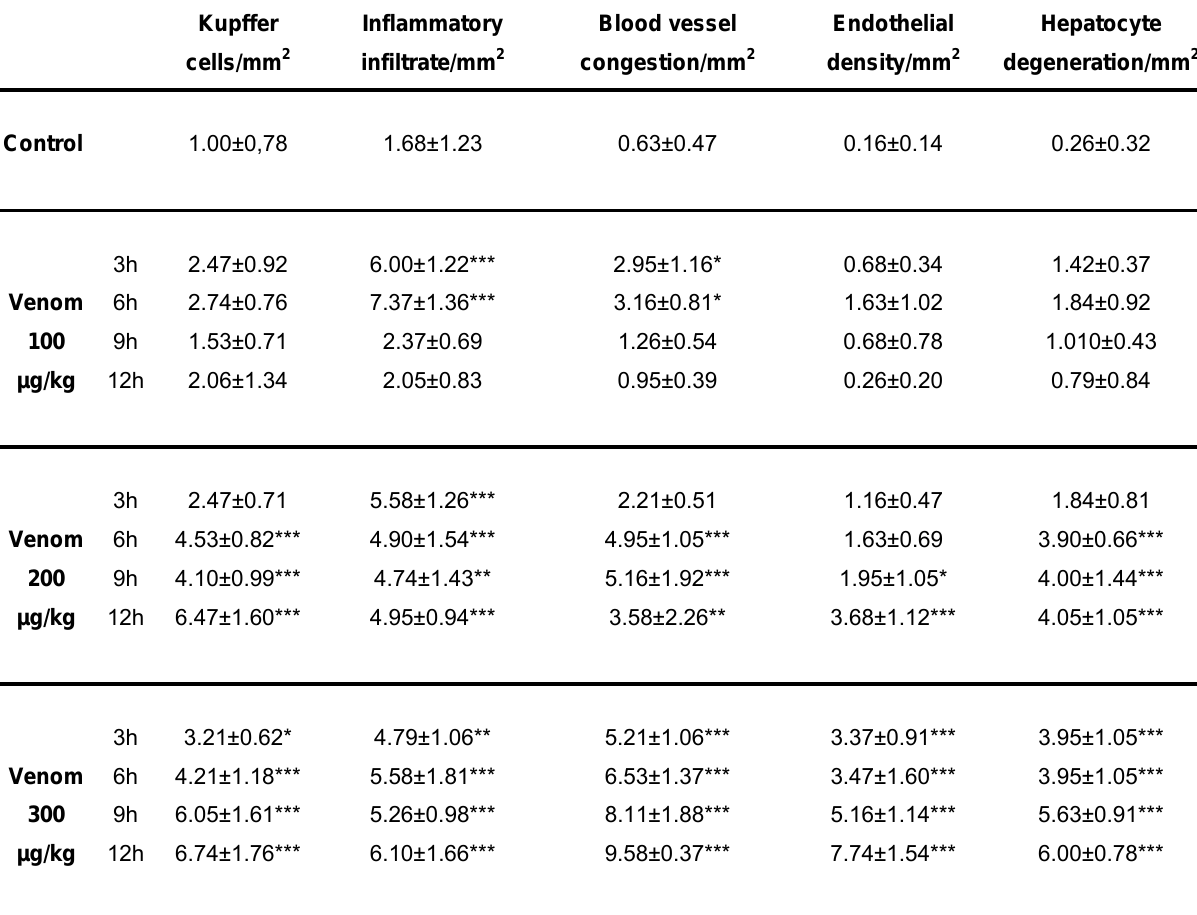
Table 1. Morphometric analysis of liver histological